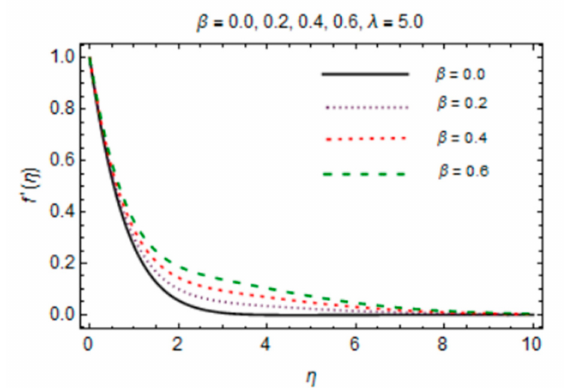
Figure 7. β verses velocity profile.